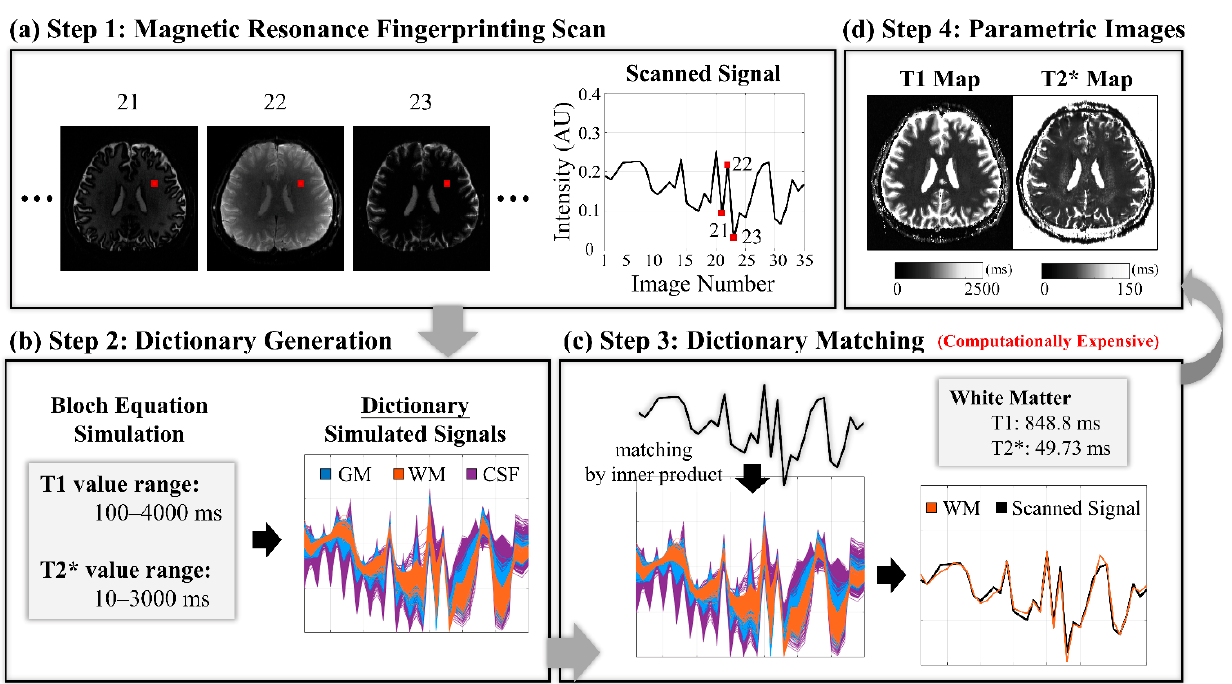
Figure 1. Schematic of the reconstruction for T1 and T2* maps of the magnetic resonance fingerprinting. ( a ) MRF baseline scan. ( b ) Dictionary generation process. ( c ) Dictionary matching by the inner product. ( d ) Parametric maps after matching pixel by pixel. MRF = magnetic resonance fingerprinting; AU = arbitrary unit; GM = gray matter; WM = white matter; CSF = cerebrospinal fluid.